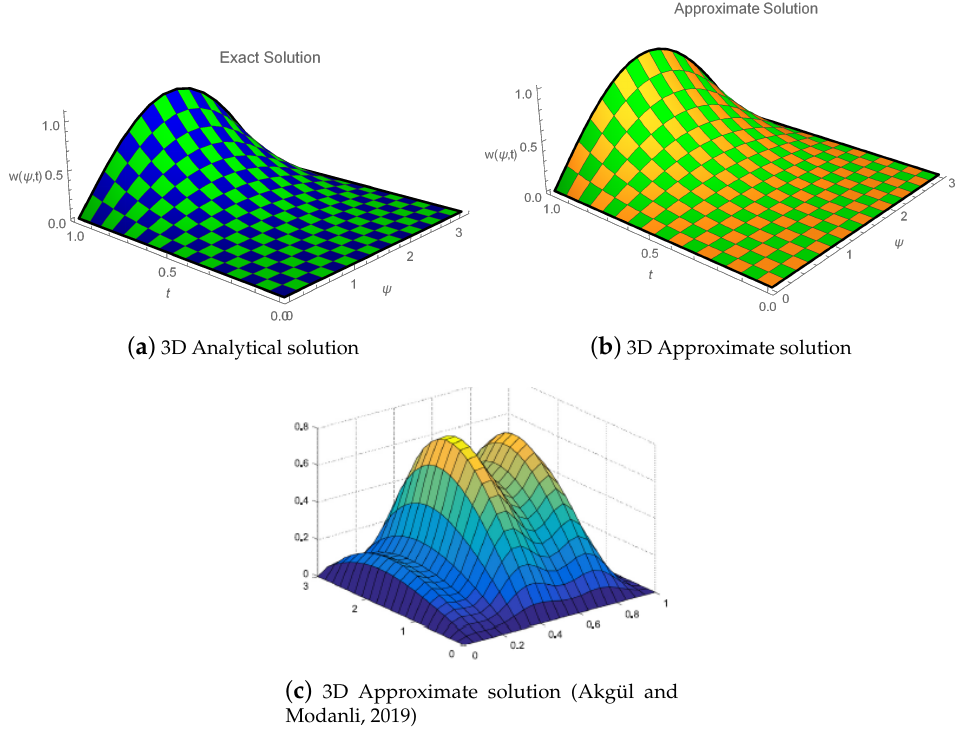
Figure 3. Comparison between 3D analytical, proposed approximate, and approximate [10] solutions of Example 1 for γ = 0.37 and ˜ M = K =